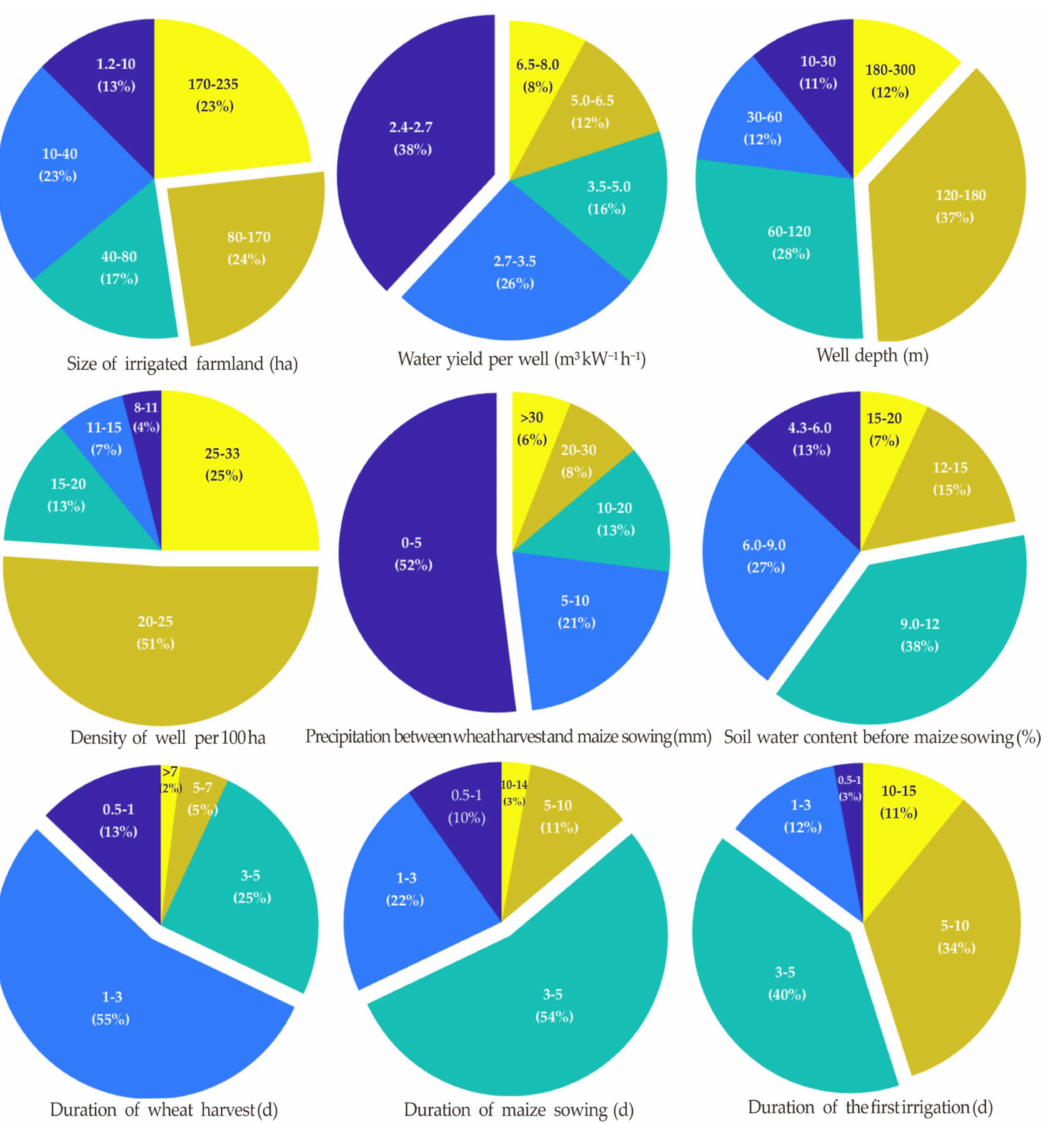
Figure 3. Proportional pie chart of surveyed